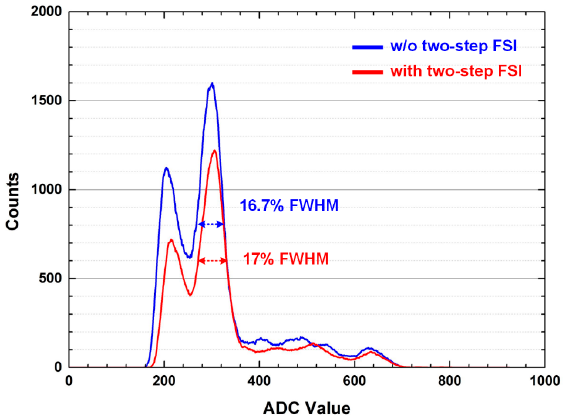
Figure 11. Measured energy spectra with and without the two-step FSI.